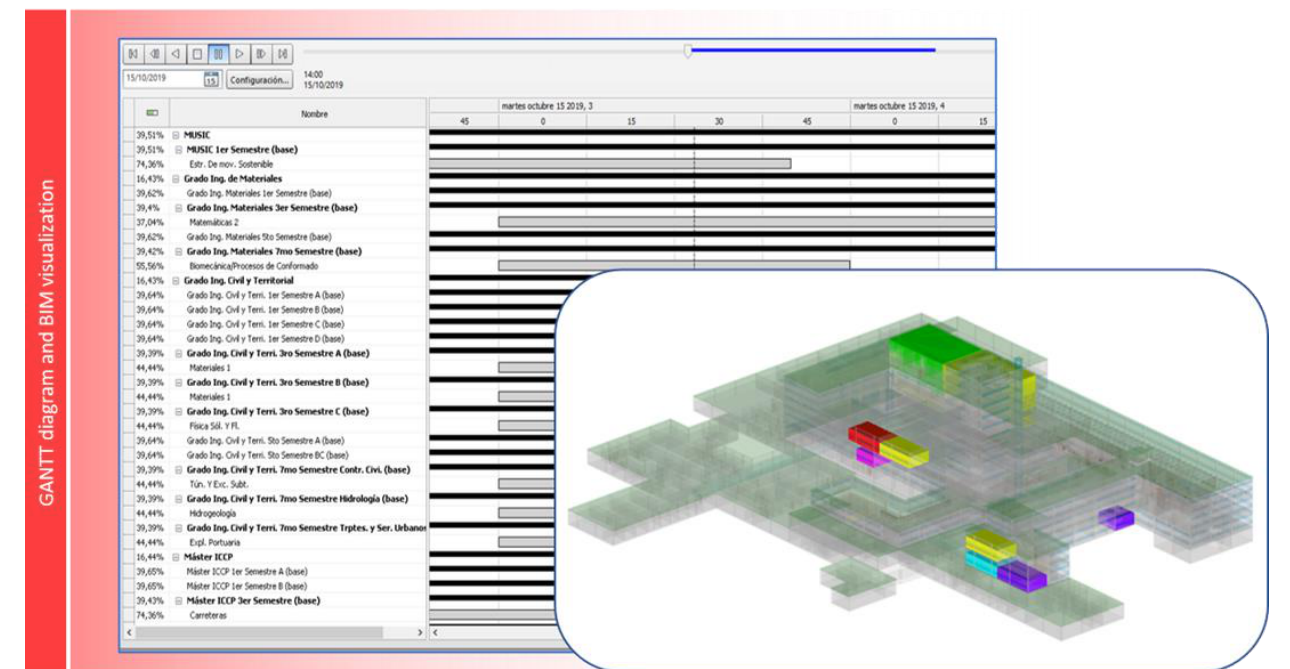
Figure 9. Educational Scheduling linked with BIM model.